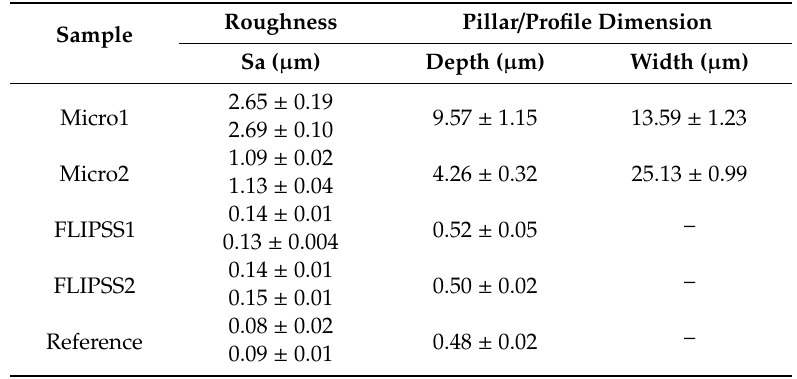
Table 2. Average area surface roughness Sa and surface micro-profile of laser-structured surfaces and reference. The values are listed separately for each